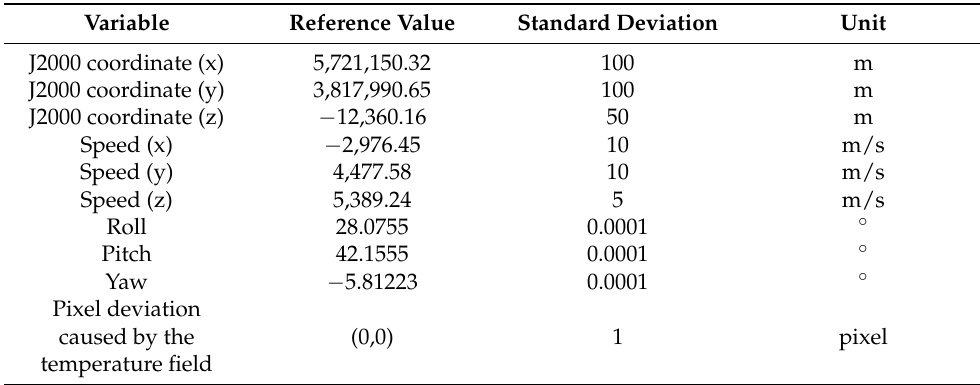
Table 2. Simulation parameters of satellite remote sensing